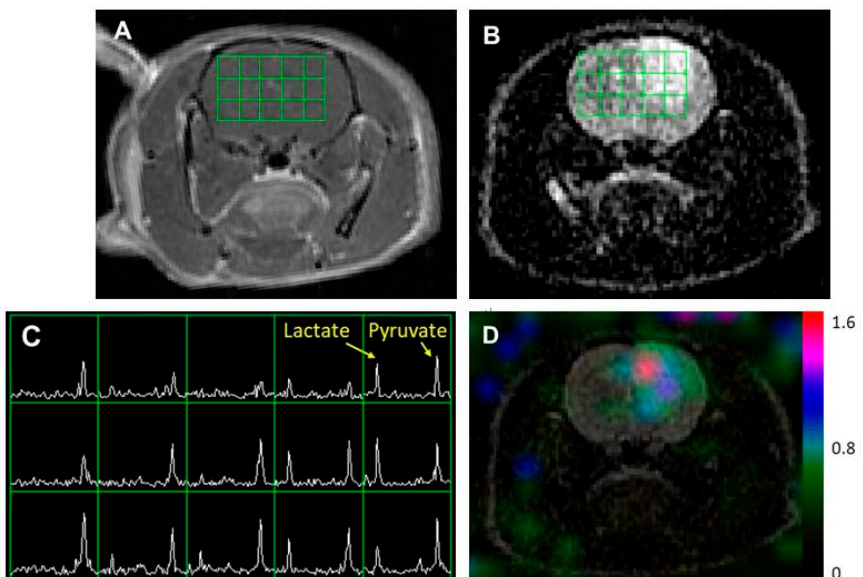
Figure 2. An example of MR imaging data from a rat model of a diffuse midline glioma. A post-Gd T1-weighted image ( A ) and T2-weighted image ( B ) showing the typical features of a non-enhancing brain tumor: hyperintensity in the T2-weighted image without contrast enhancement. The grid in ( A , B ) represents the array of 13 C spectroscopic imaging data over the brain ( C ) with an in-plane voxel resolution of 2 × 2 mm, showing hyperpolarized metabolite signals from pyruvate and lactate. The color overlay map of the ratio of lactate to pyruvate in ( D ) shows an elevated level of lactate in the non-enhancing lesion compared to the surrounding tissue.